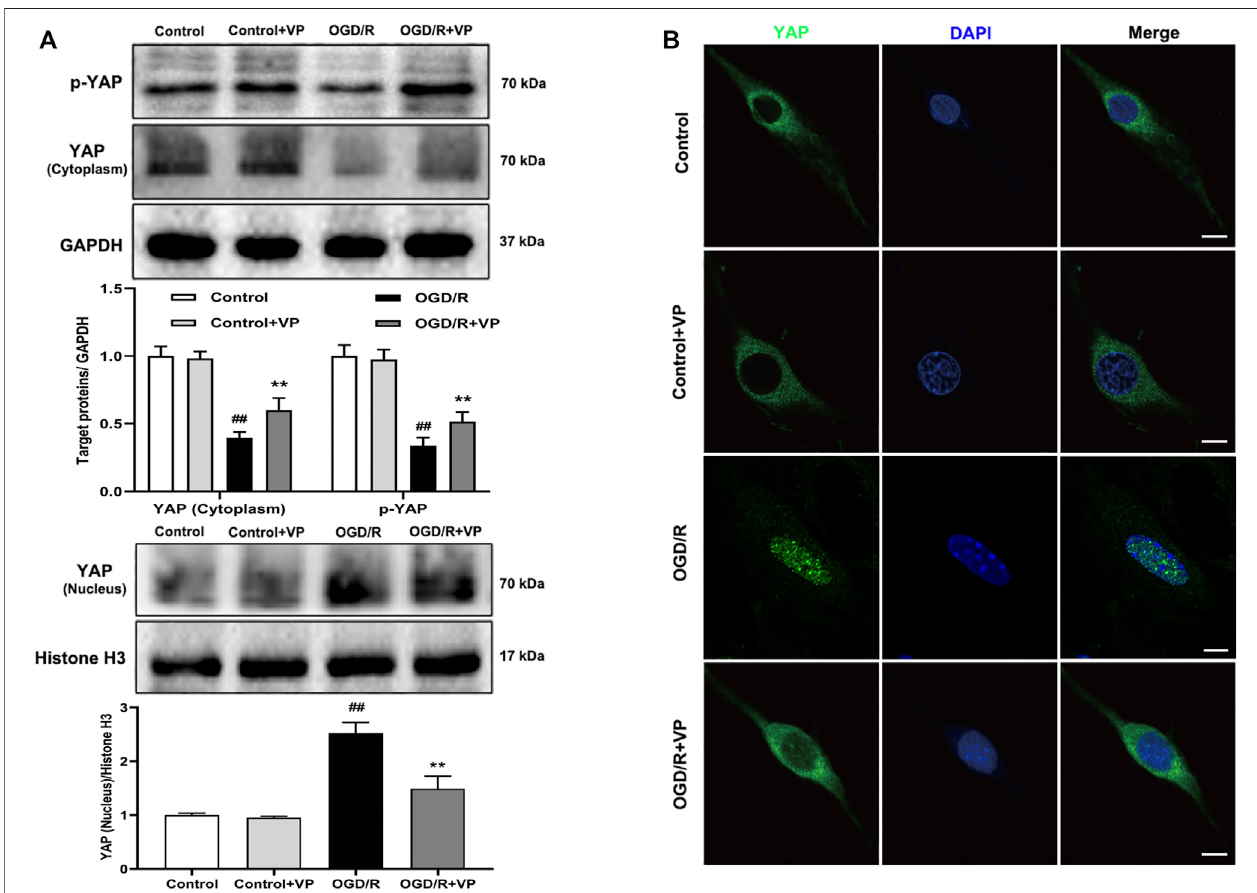
FIGURE6| Effects ofVPtreatmentonYAP/p-YAP expression levelsfollowingOGD/Rinjuryinbrainendothelial cells.bEnd.3 cellsweretreatedwithVP(1 µM)and subsequentlyexposedto6 hofOGDand6 hofreoxygenation. (A) Representativewesternblotsandquantitativeanalysesshowingtheexpressionlevelsofp-YAP,YAP (cytoplasm), and YAP (nucleus) in vitro . (B) Representative microscopic images of YAP (green) based on immuno fl uorescence analyses. DAPI-stained nuclei are depicted in blue. Data are expressed as the mean ± SD, n (cid:1) 6. ## p < 0.01 vs . Control group, ** p < 0.01 vs . OGD/R group. Scale bar (cid:1) 50 µm.